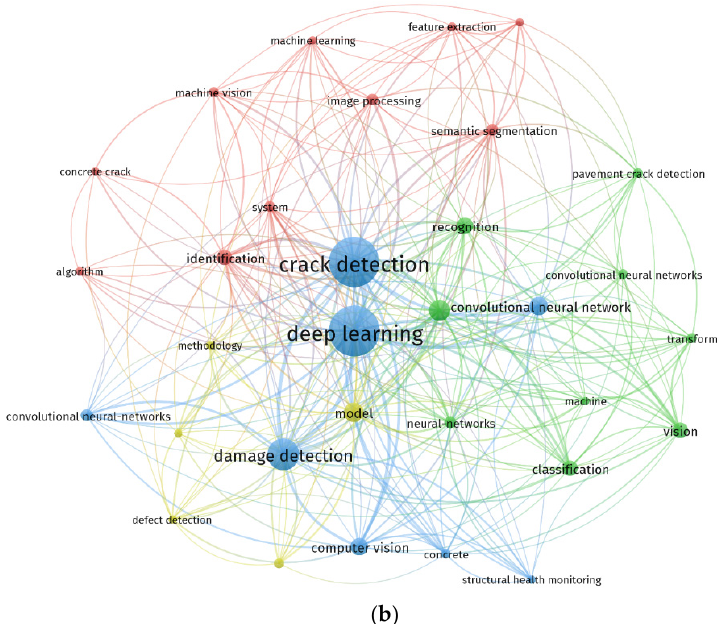
Figure 6. Scientometric mapping of Scopus and WoS keywords. ( a ) Scopus keyword mapping, ( b ) WoS keyword mapping.